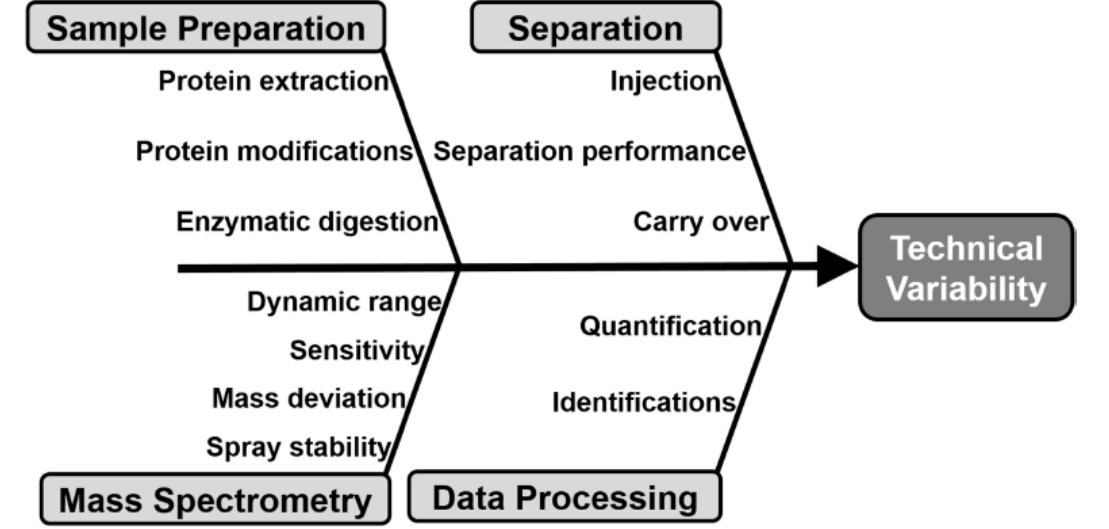
Figure 8. Fishbone diagram highlighting the principal sources of variability in a MS-based proteomic experiment that should be evaluated during system suitability assessment.